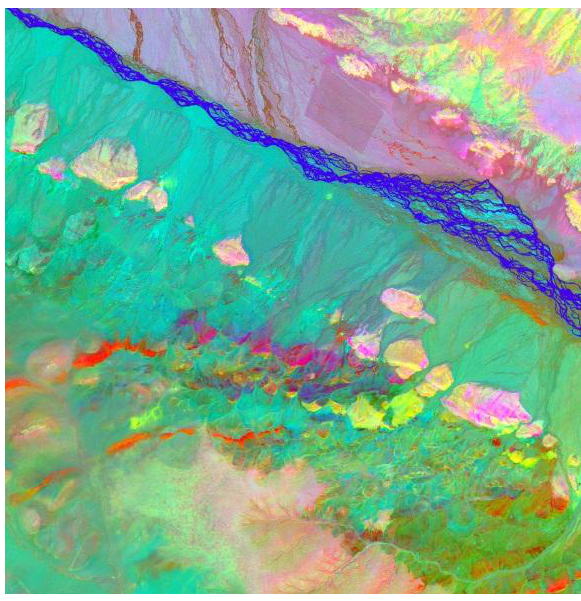
Figure 3 mnf531 band